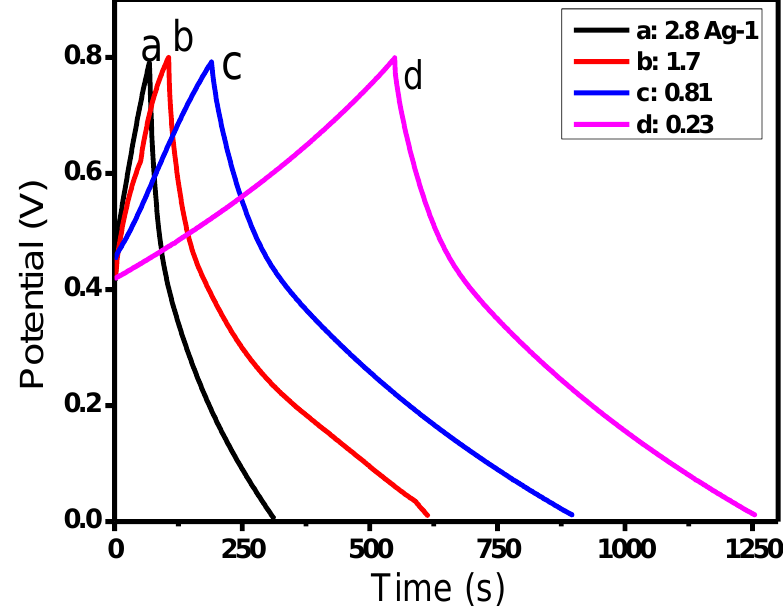
Figure 11. GCD curves of RGO/COP at different current densities as indicated.